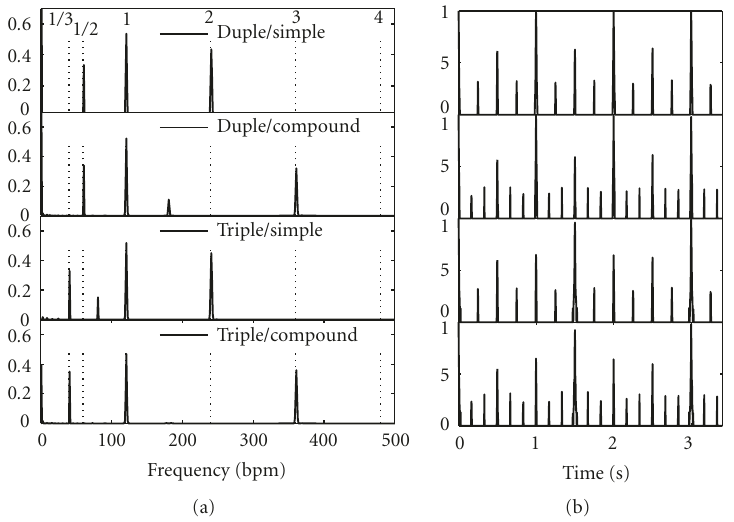
Figure 6: (a) Metrical patterns of the combined DFT/FM-ACF for a tempo of 120 bpm and various theoretical typical rhythms; (b) corre- sponding temporal signals.